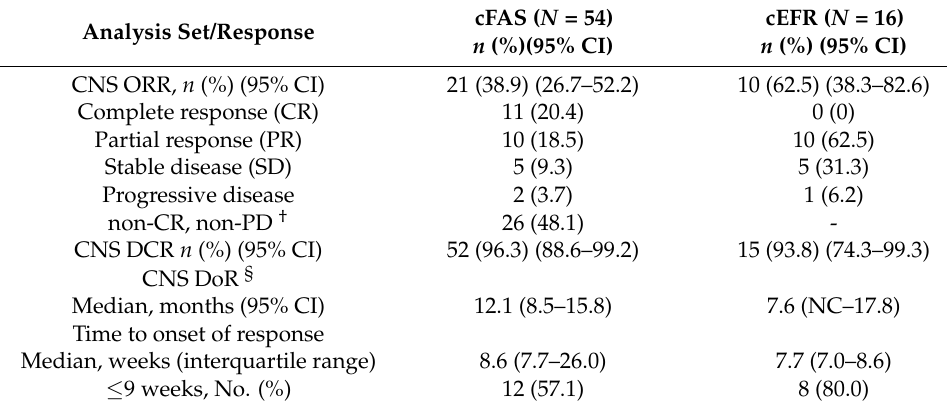
Figure 2. Kaplan–Meier estimates of total ( A ) overall survival and ( B ) progression-free survival. Table 2. CNS response to osimertinib.